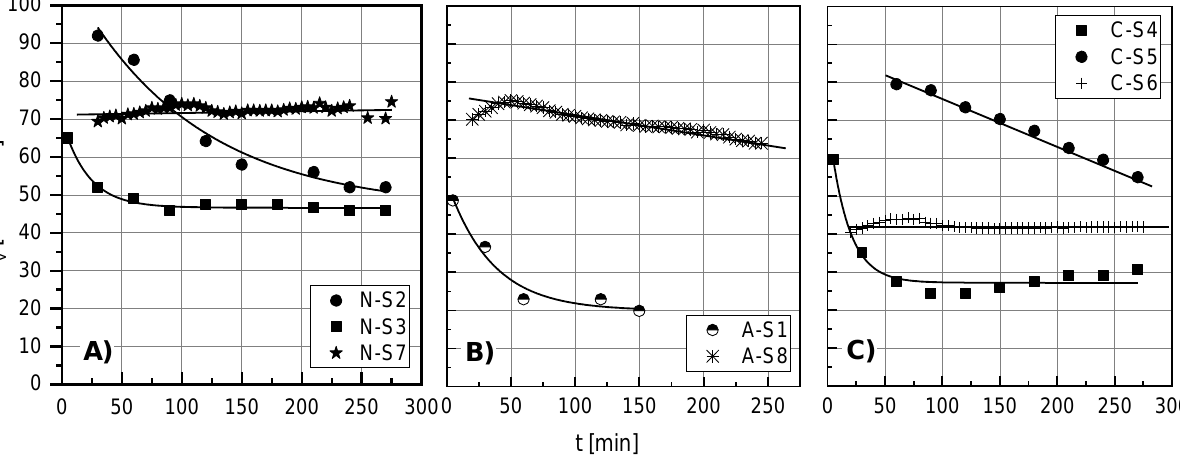
Figure 4. Influence of the surfactant type on the permeate flux ( J v ): ( A ) MTW containing nonionic surfactants; ( B ) MTW containing anionic surfactants; ( C ) MTW containing cationic surfactants.